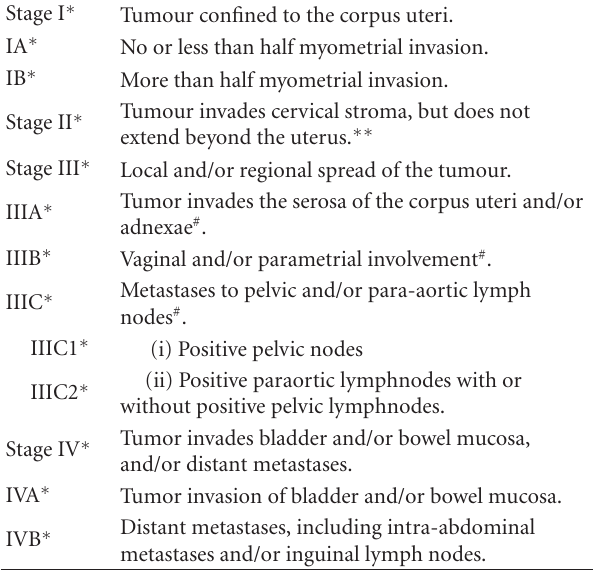
Table 1: Carcinoma of the corpus uteri (FIGO